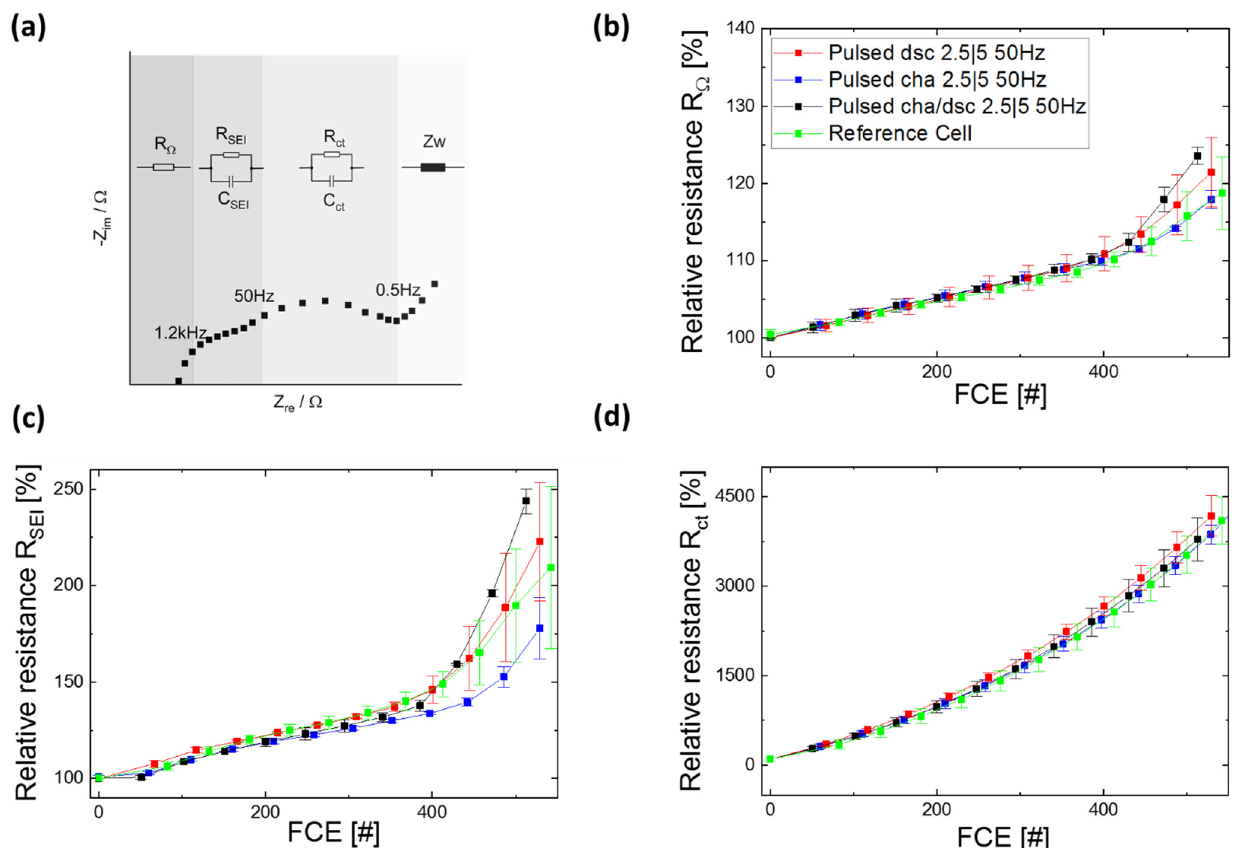
Figure 9. ( a ) schematic presentation of the electric circuit used for the quantitative evaluation of the electrochemical impedance spectra at 100% SOC over 550 FCE; development of the ( b ) relative Ohmic resistance, ( c ) relative SEI resistance and ( d ) relative charge transfer resistance, as a function of the FCE.